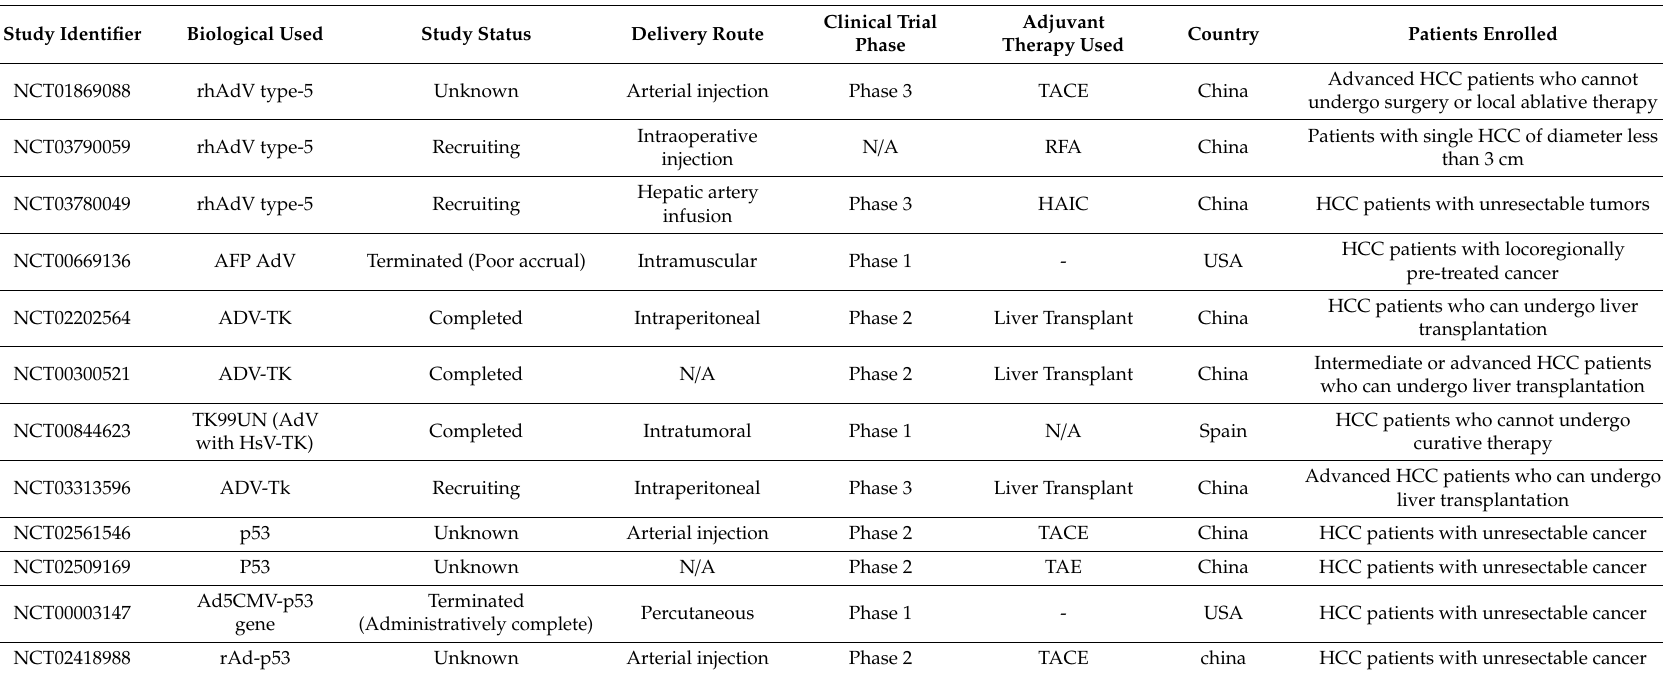
Table 3. Data from clinicaltrials.gov as of 07.13.2019 showing clinical trials that use adenoviruses to treat